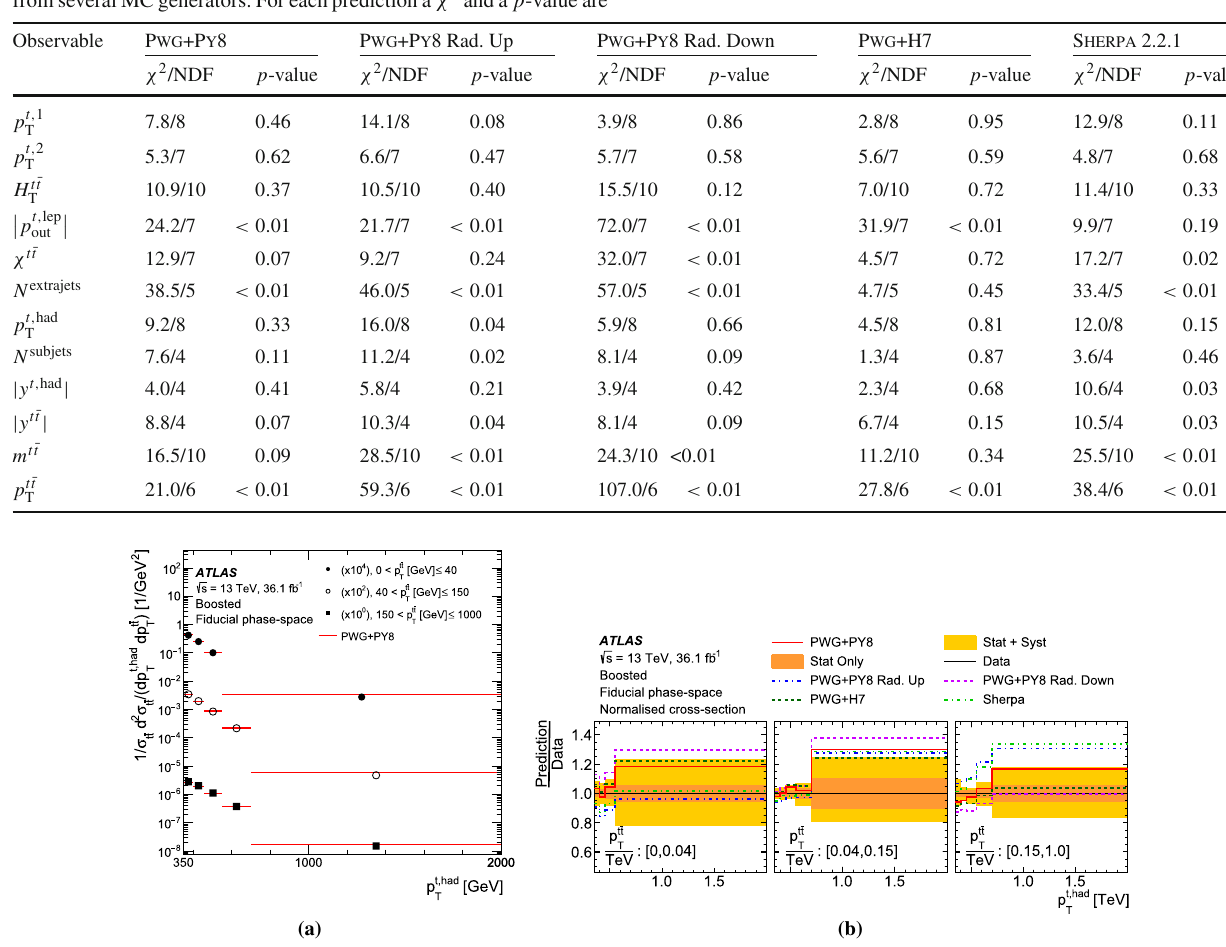
calculated using the covariance matrix of the measured spectrum. The NDF is equal to the number of bins in the distribution